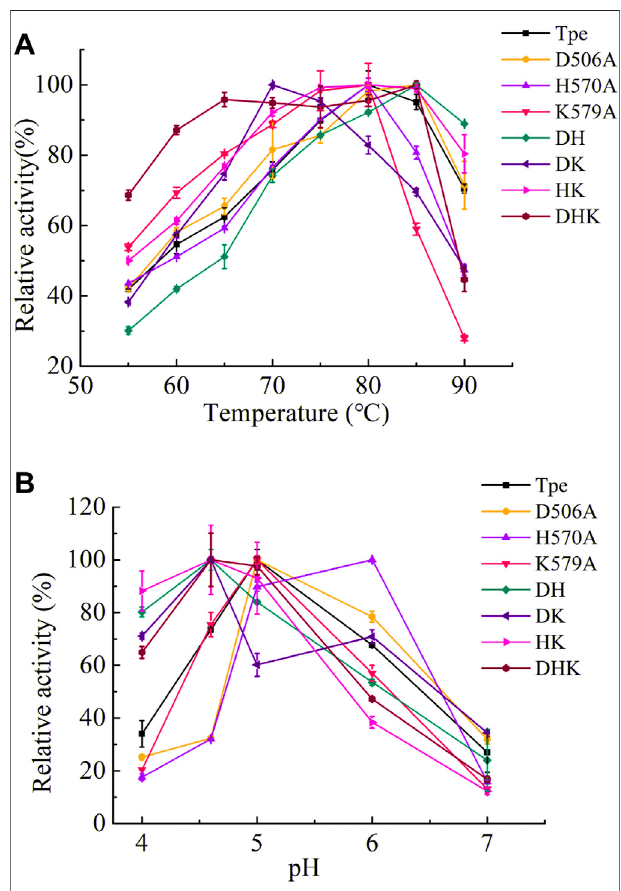
FIGURE 3 | The optimal conditions of TpeRha and mutants. (A) The optimal temperatures of TpeRha and mutants. (B) The optimal pH values of TpeRha and